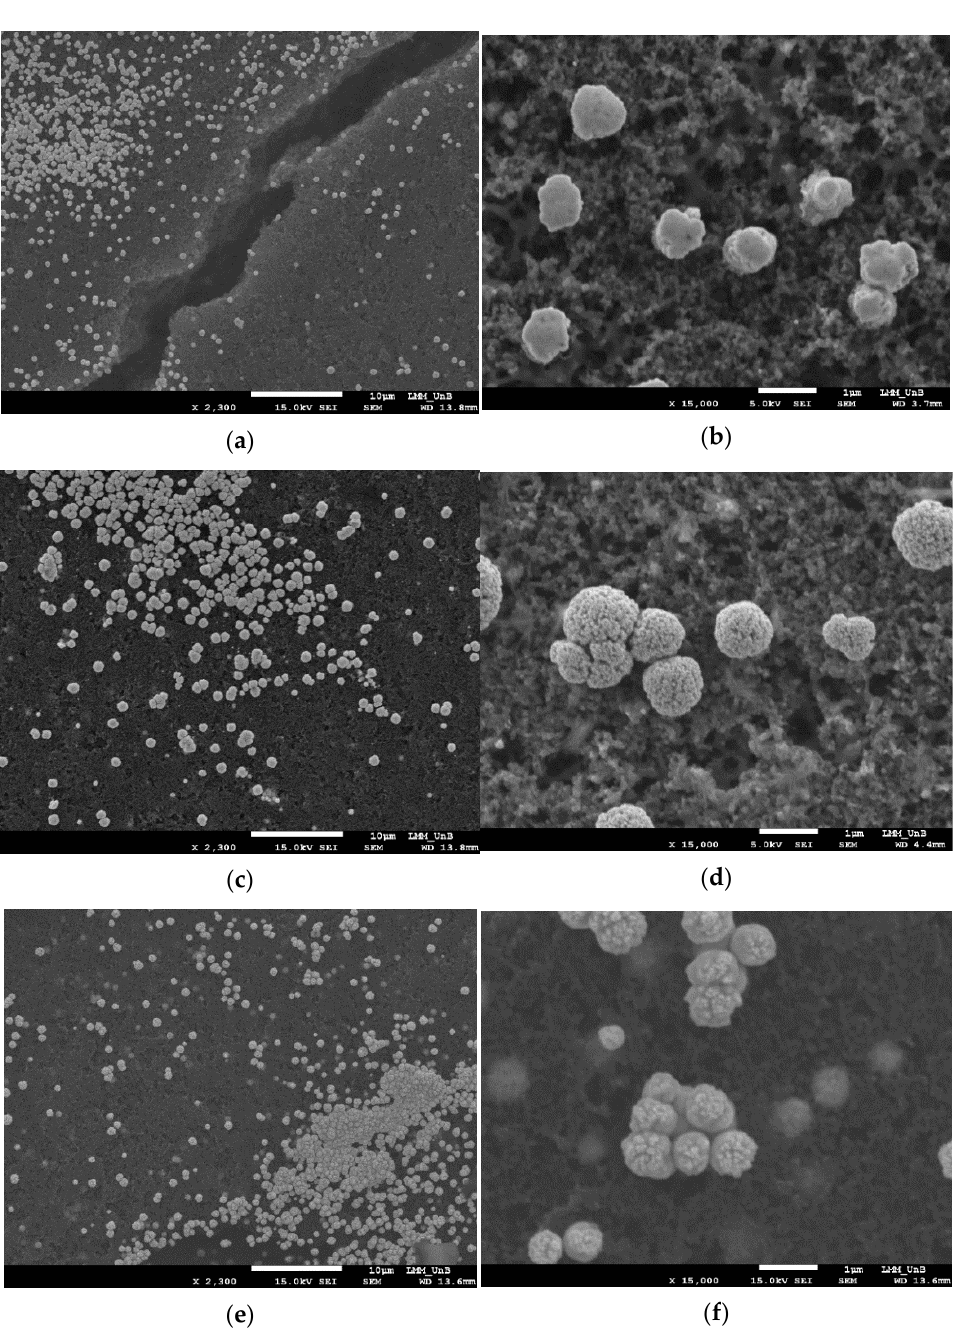
Figure 3. SEM images of the different Pt@DL catalysts hydrothermally reduced with ( a , b ) FA120200: ( c , d ) EG160200; ( e , f ) ET120300. Table 2. Average particle size for the Pt@GDL electrodes studied.